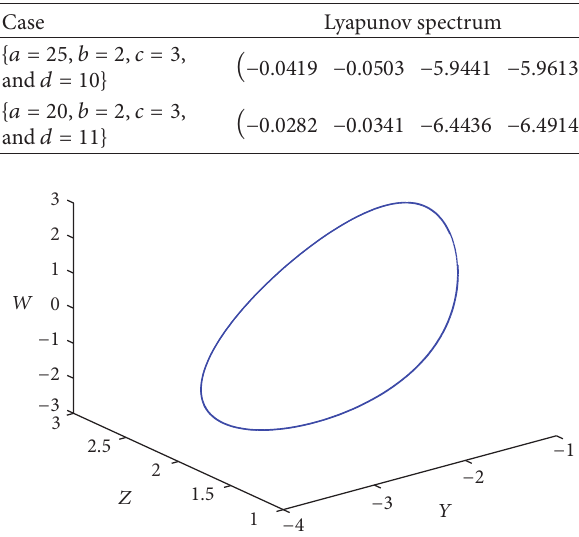
Figure 3: Projection over the subspace YZW of the limit cycle of new system, working in regular region (𝑎 = 25 and 𝑑 = 10) .